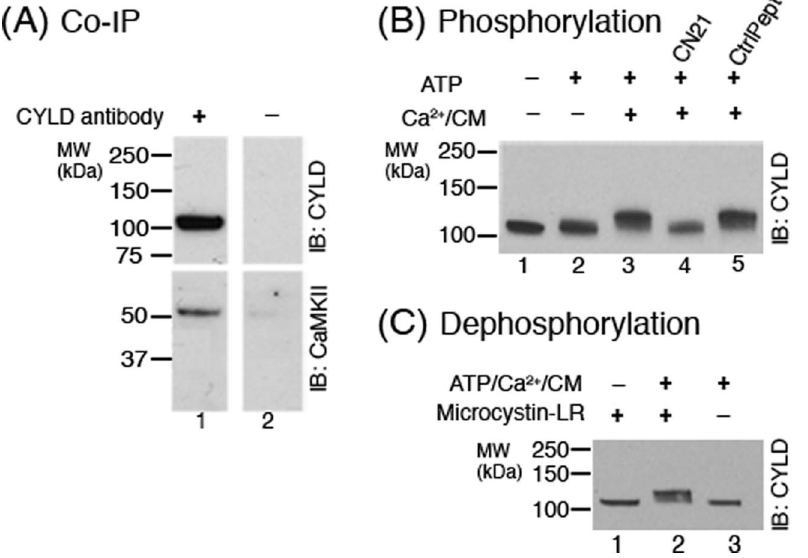
Figure 2. CaMKII co-immunoprecipitates with CYLD and promotes phosphorylation of CYLD at the PSD. ( A ) CYLD in solubilized PSD fractions was immunoprecipitated using CYLD antibody, followed by Western immunoblotting with antibodies for either CYLD or CaMKII. CaMKII co- immunoprecipitated with CYLD while neither protein was detected when beads without CYLD antibody were used. Two independent experiments yielded similar results. ( B ) PSD fractions were incubated under various conditions designed to manipulate CaMKII activity, followed by Western immunoblotting with CYLD antibody. Addition of Ca 2 + /calmodulin along with ATP caused a distinct mobility shift in CYLD (lane 3), indicative of phosphorylation. The mobility shift was prevented upon addition of CN21, a CaMKII inhibitor (lane 4). The control peptide had no appreciable effect on the observed mobility shift (lane 5). Two independent experiments yielded similar results. ( C ) PSD fractions were incubated under conditions designed to manipulate endogenous kinases and phosphatases at the PSD, followed by Western immunoblotting with CYLD antibody. The mobility shift elicited by ATP/Ca 2 + /CM was reversed upon incubation in the absence of the phosphatase inhibitor MicrocystinLR (lane 3). doi:10.1371/journal.pone.0091312.g002 PLOS ONE |